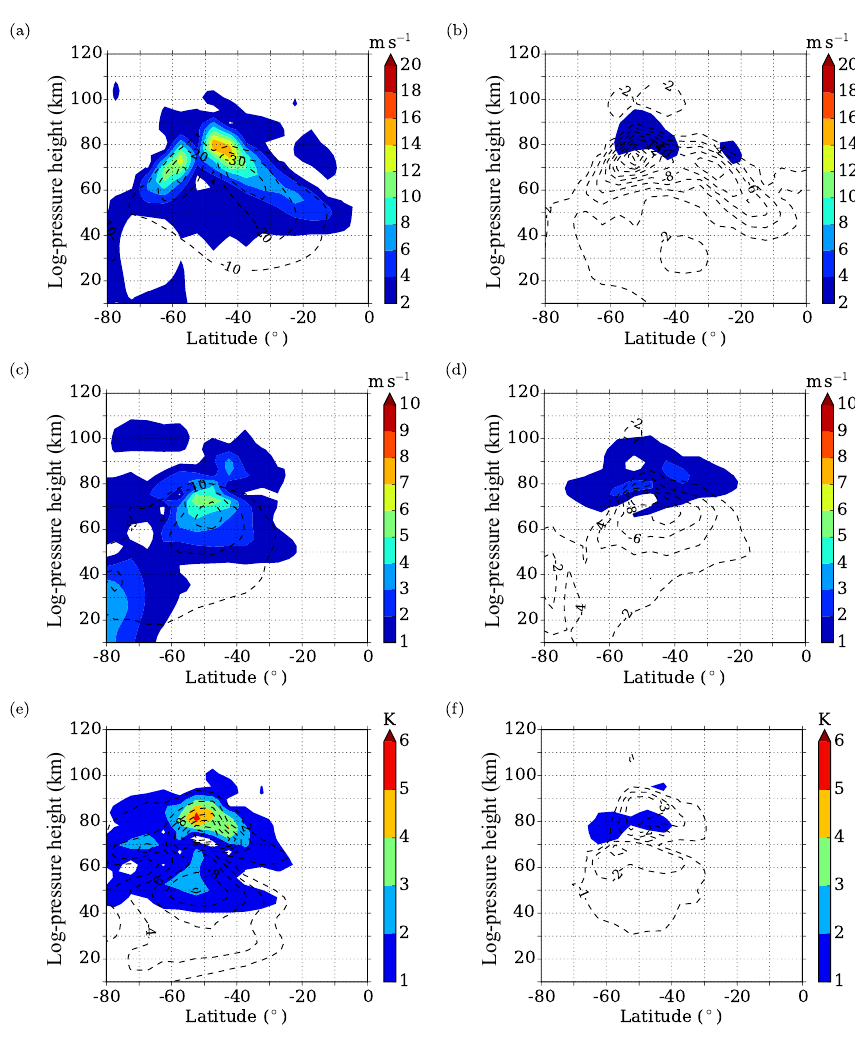
Figure 7. Run3: zonal wind (a, b) , meridional wind (c, d) and temperature (e, f) amplitudes of SPW1 (left column: a, c, e ) and SPW2 (right column: b, d, f ) as background colors. Run3–Run2 differences are added as isolines in steps of 10ms − 1 (a, c) , 2ms − 1 (b, d) , 2K (e) , and 1K (f) .